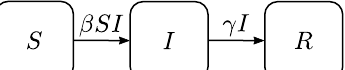
Figure 1. Scheme of the basic SIR model. Boxes represent compartments, and arrows indicate flux between the